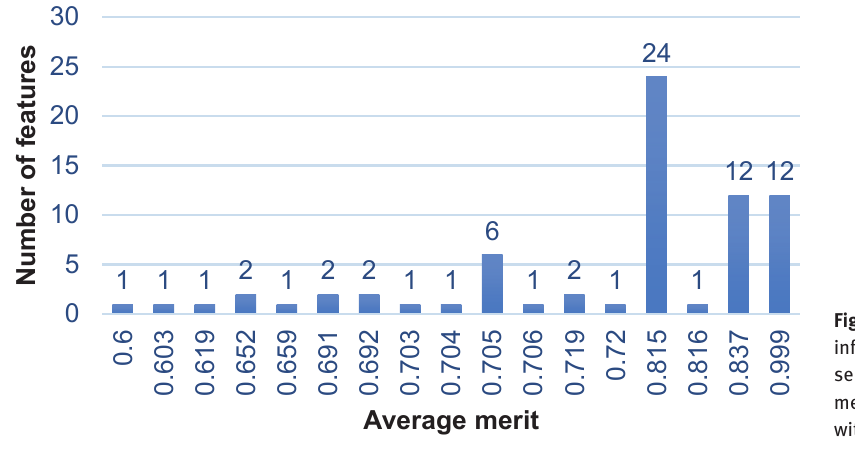
Figure 2: Average merit of information gain attribute selection after used metalearner-correlation-KLR with 10-fold cross-validation.